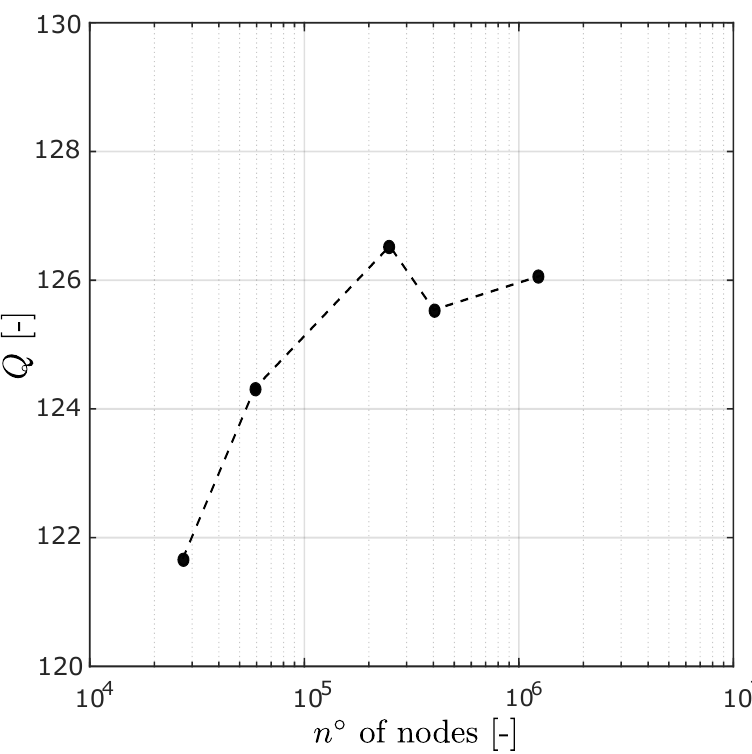
Figure 9. Mesh convergence analysis in Micromirror 1 for α = 13.00 ◦ , with a semilogarithmic scale on the abscissa. We highlight that the computed quality factor does not show a remarkable dependence on the mesh refinement, hence suggesting that the analysis has reached